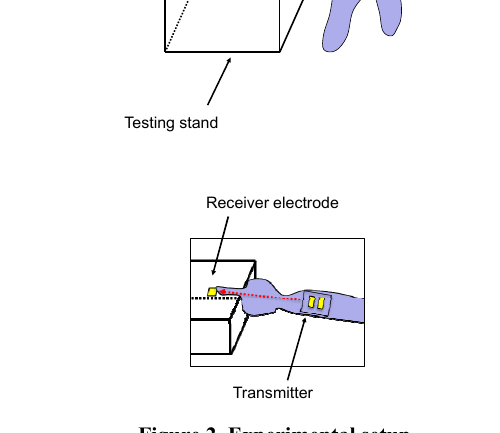
Figure 2. Experimental